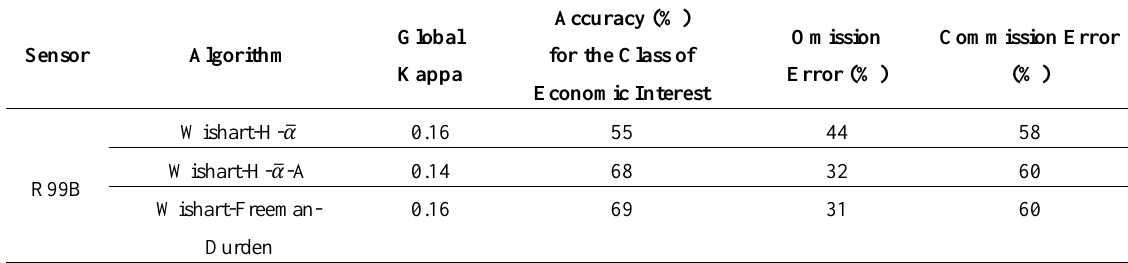
Table 3. Parameters derived from the error matrix for the evaluation of the performance of the hybrid algorithms of polarimetric classification for the R99B and RADARSAT-2 images: global Kappa, accuracy for the class of economic interest, omission and commission